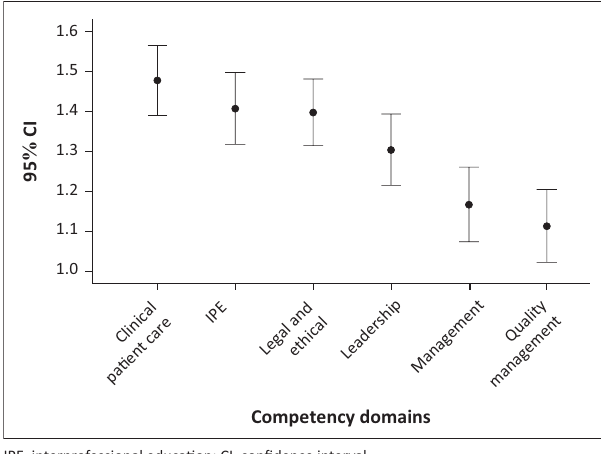
FIGURE 1: Competence ratings of the competency domains. TABLE 1: Competency ratings for clinical practice domain.